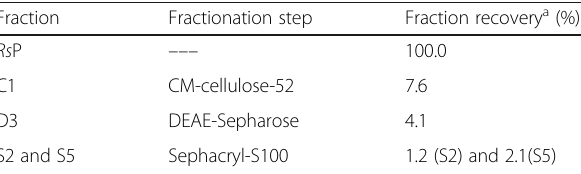
Table 1 Recovery of the chromatographic components obtained during the fractionation procedure Fraction Fractionation step Fraction recovery a (%) Rs P –––